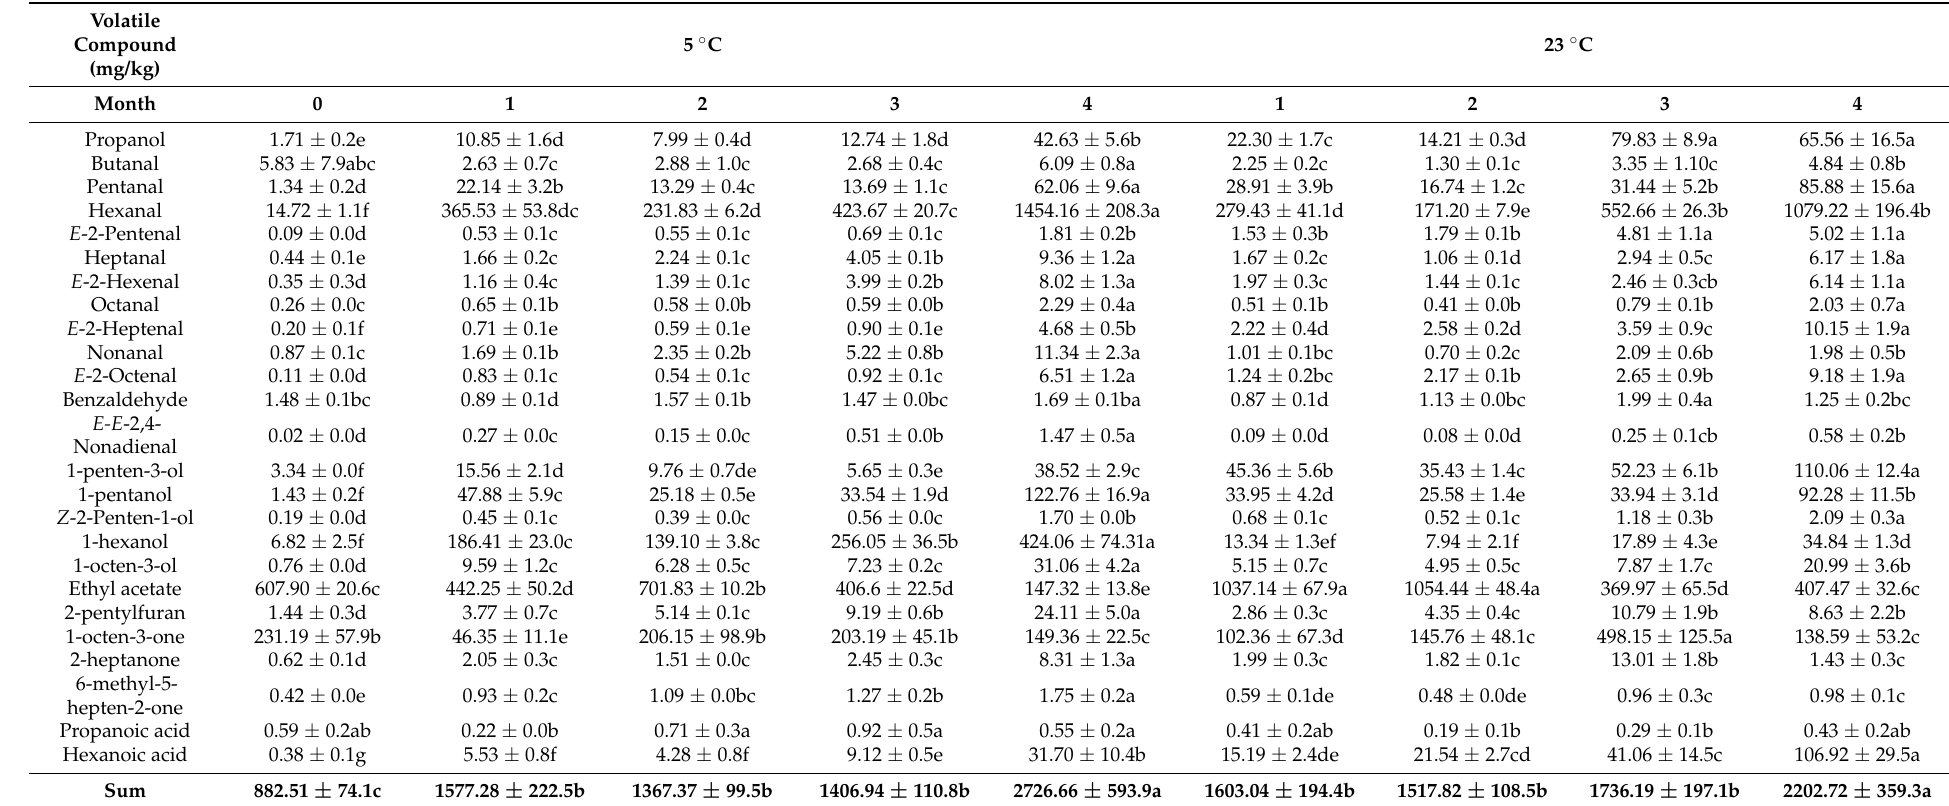
Table 5. Volatile changes in Chandler kernels during